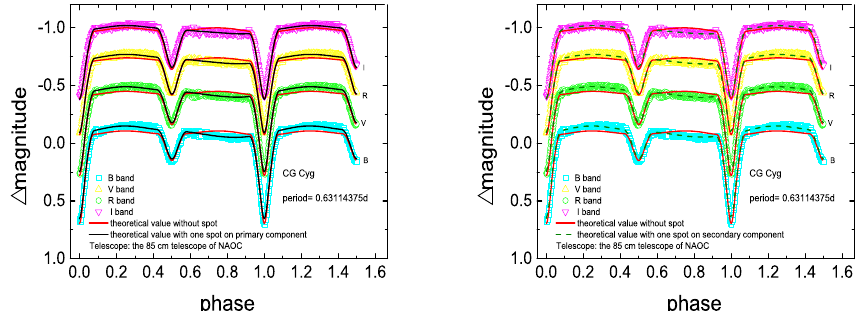
Figure 3. The theoretical and observational light curves of CG Cyg, where the left panel shows the model with a spot on the primary component, and the right panel shows the model with spot on the secondary